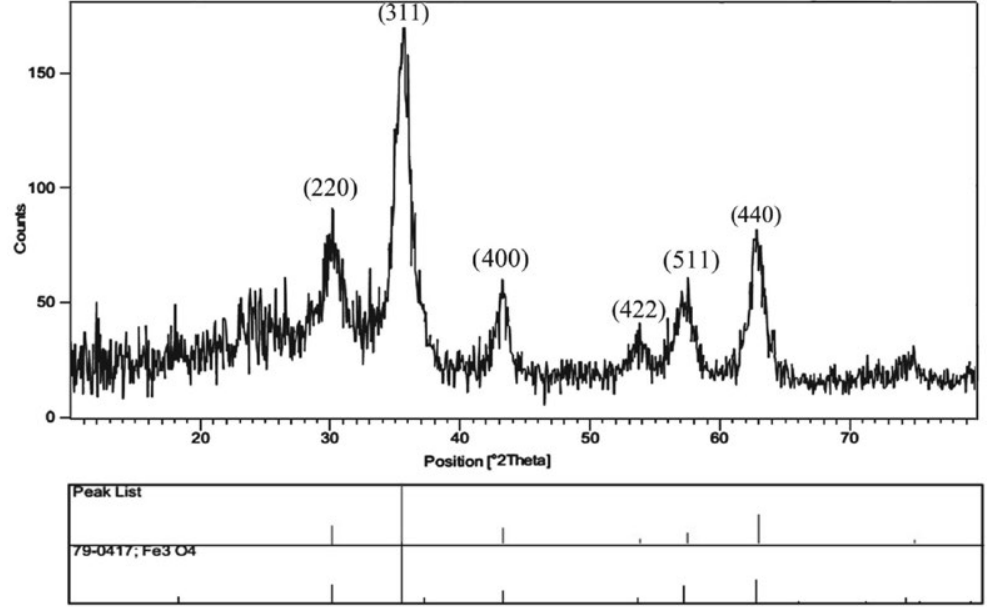
Figure 4 . The XRD pattern of Fe